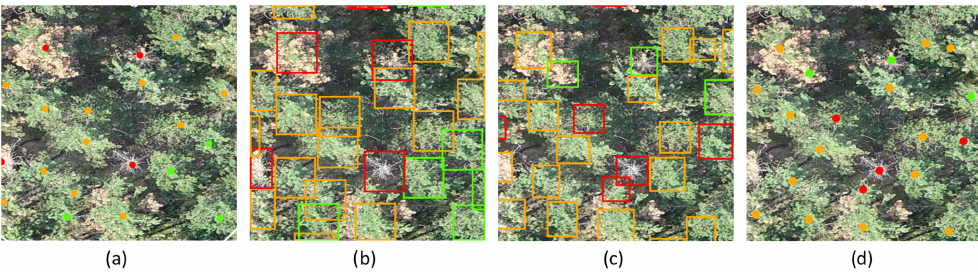
Figure 4. Different labels on the same image with healthy black pines (green), damaged black pines (orange), and dead black pines (red). The image coincidentally contains no deciduous trees or other conifers. ( a ) Point labels from a previous investigation; ( b ) bounding boxes converted from point labels in ( a ) using the optimal edge length; ( c ) output bounding boxes from the final model; ( d ) point labels converted from output bounding boxes in ( c